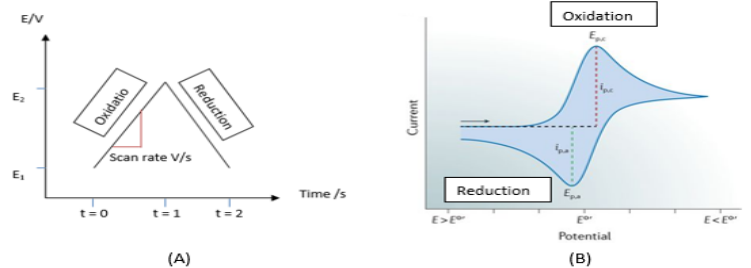
Figure 6. Cyclic voltammetry curves for detailed oxidation and reduction data. ( A ) Scan rate and GOx activity function with potential overtime. ( B ) The cyclic voltammogram.